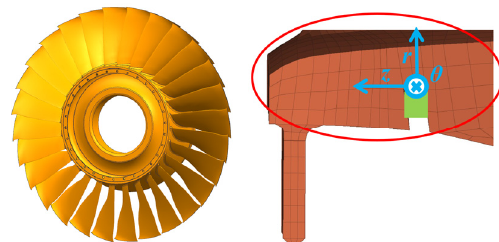
Aerospace 2021 , 8 , x FOR PEER REVIEW Figure 13. Blisk ‐ ring dry friction system. Figure 13. Blisk-ring dry friction system.